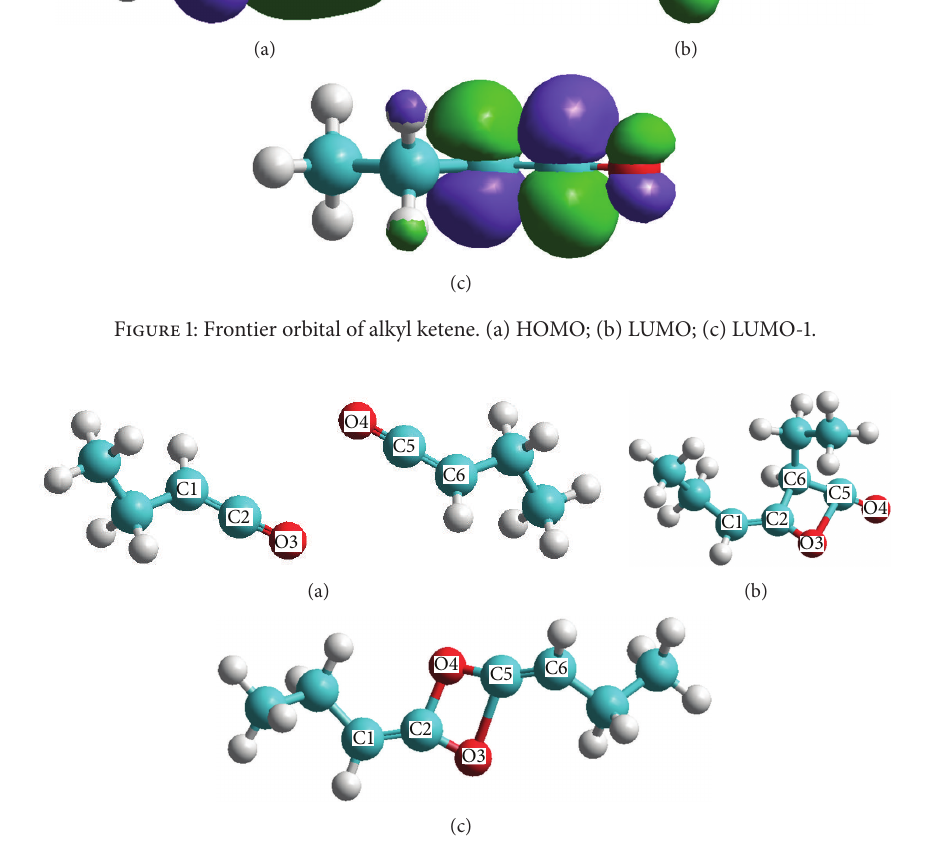
Figure 2: The optimized structures of reactant (a) and transition states ((b): TS1; (c): TS2). are shown in Figure 2, in which the two transition states represent two different pathways (reactions (1) and